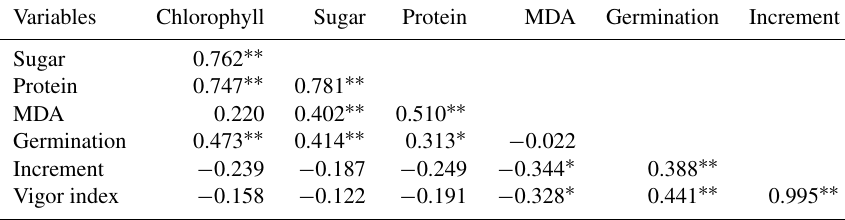
Table 3. Correlation coefficients between physiological indices and germination parameters across all mosses and